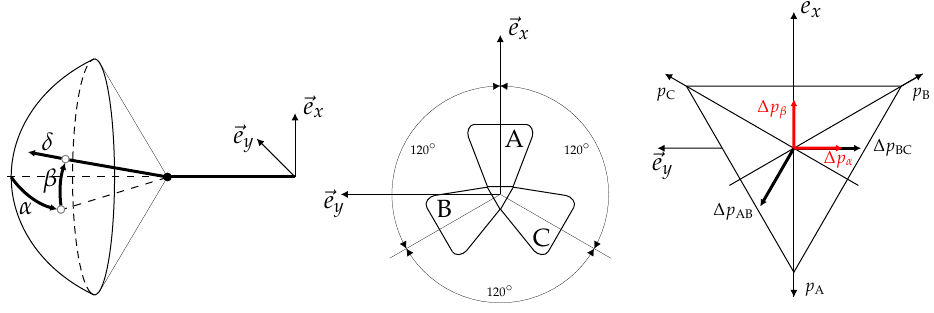
Figure 7. ( Left ) The spherical robot arm when mounted horizontally to a wall. The soft joint is indicated by the black circle and the gravitational vector points in the negative (cid:126) e x direction. The end effector point is parameterized by two extrinsic Euler angles α , β , both describing rotations with respect to the inertial frame, and the variable δ describing a longitudinal elongation. ( Middle ) The symmetric actuator configuration with the three actuators A, B, and C in the corresponding coordinate system. ( Right ) The variables used by the control allocation strategy. Note that an increase in the actuator pressure A acts in the negative x